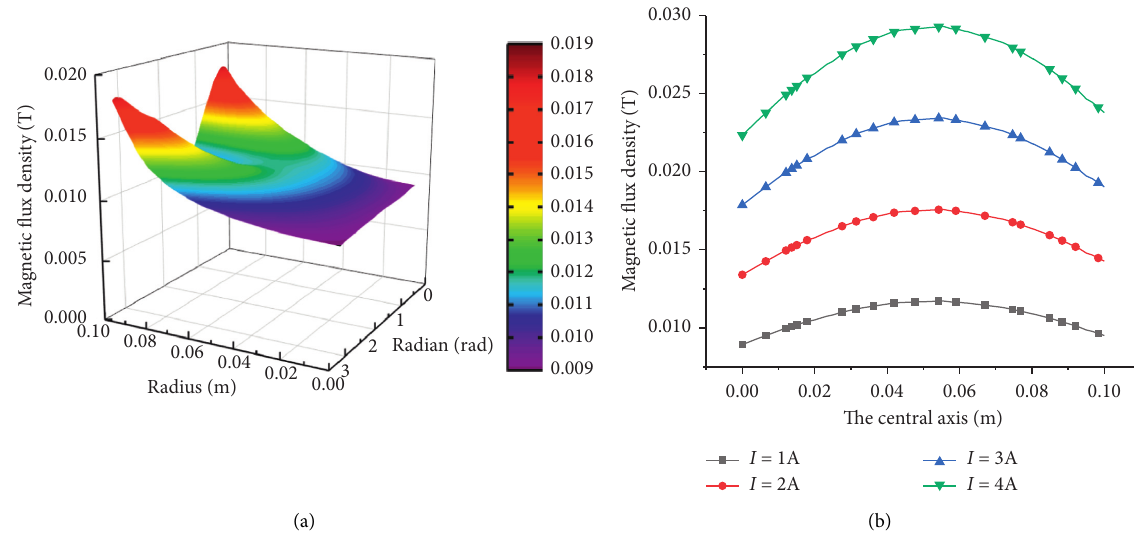
Figure 4: The magnetic field distribution. (a) Inside the groove of the damper. (b) On the central axis of the damper.